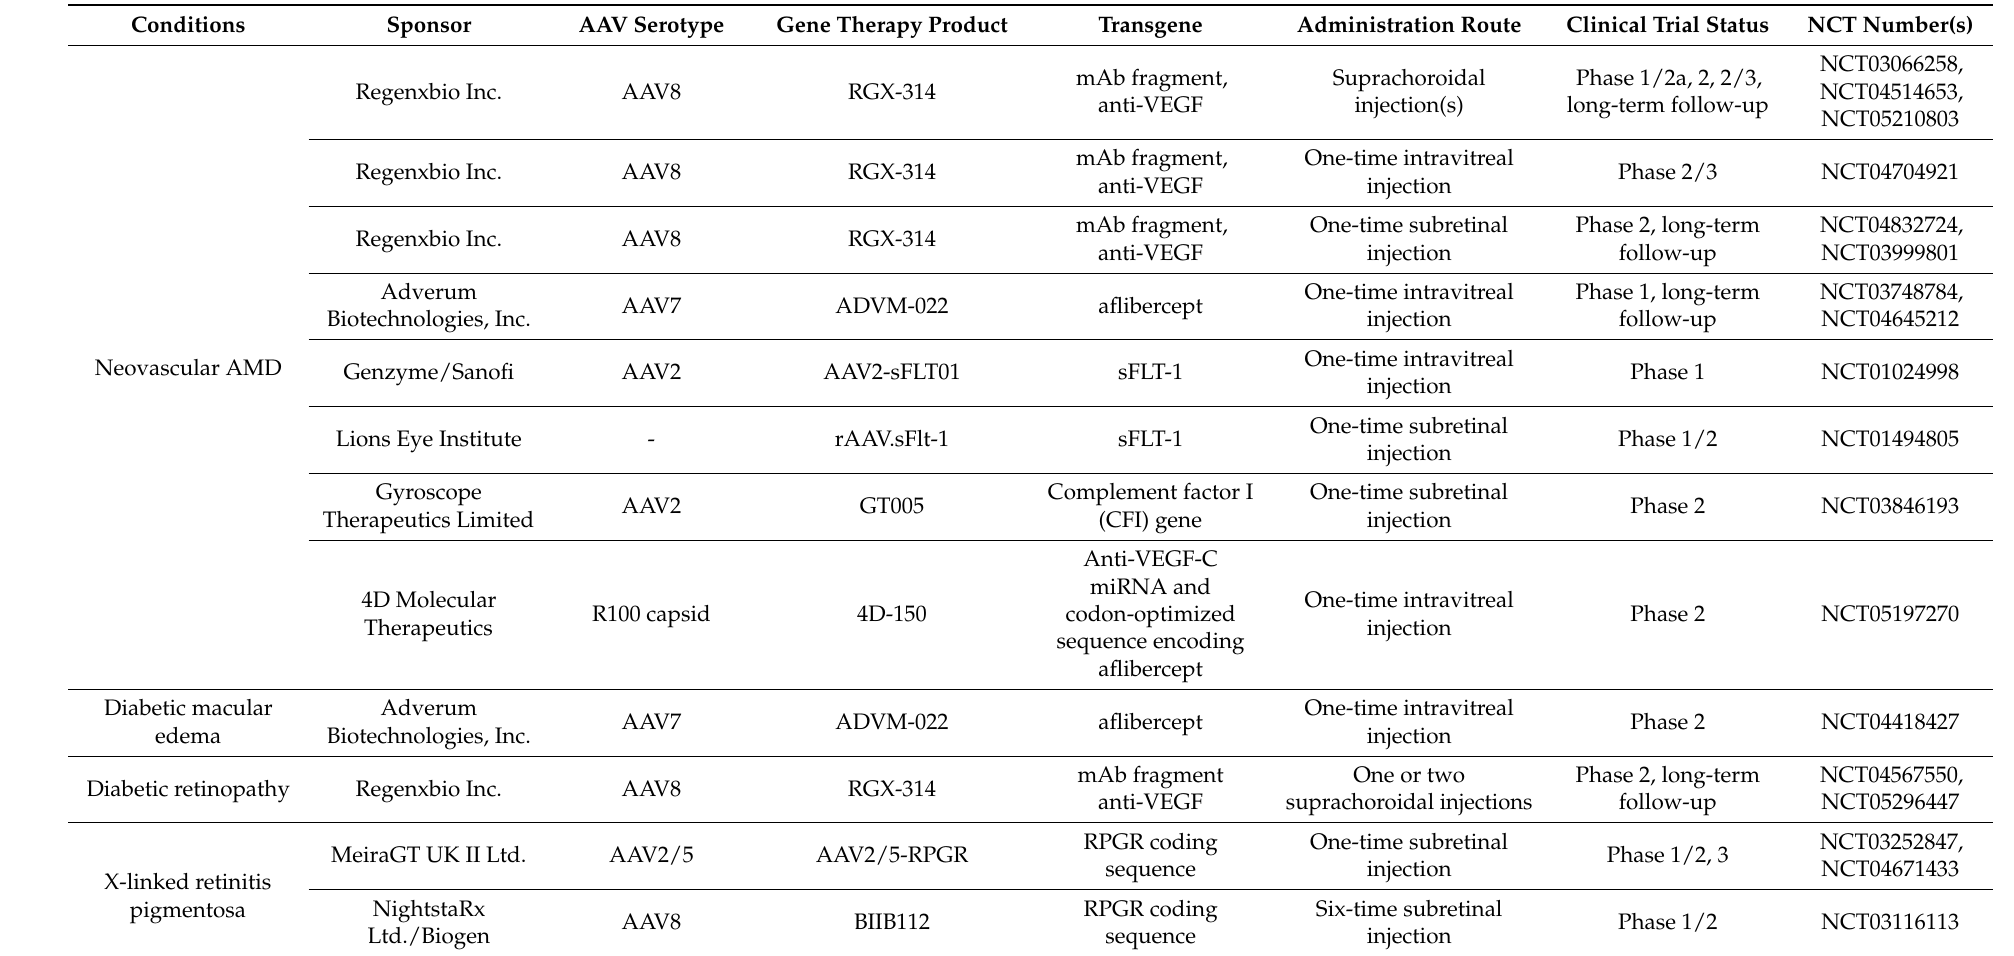
Table 1. Current and past clinical trials using AAVs as vectors for gene